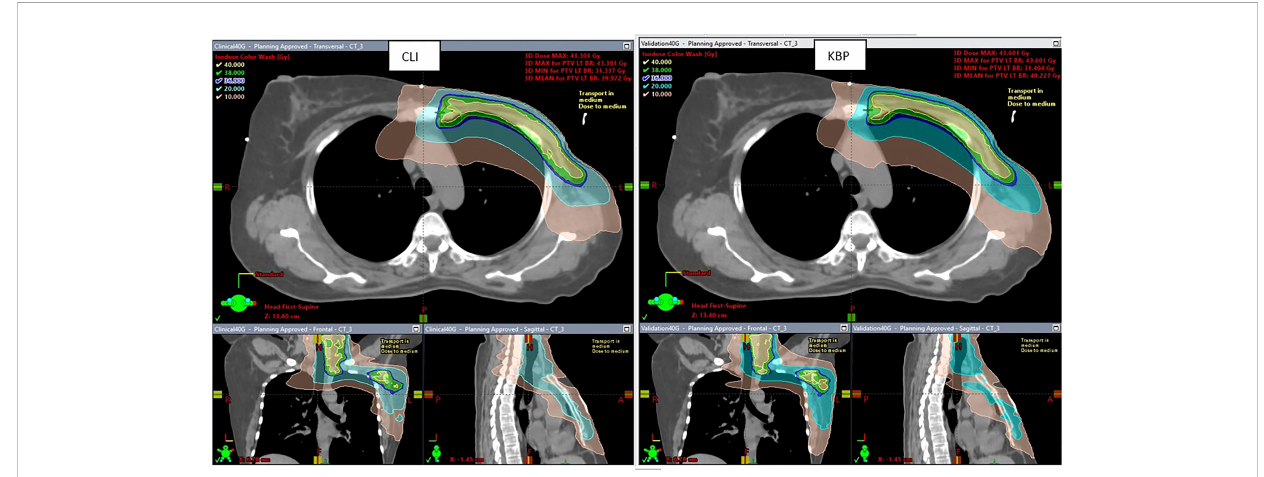
FIGURE 2 Representative dose distribution for comparison of CLI vs KBP_40 Gy in15 fractions.